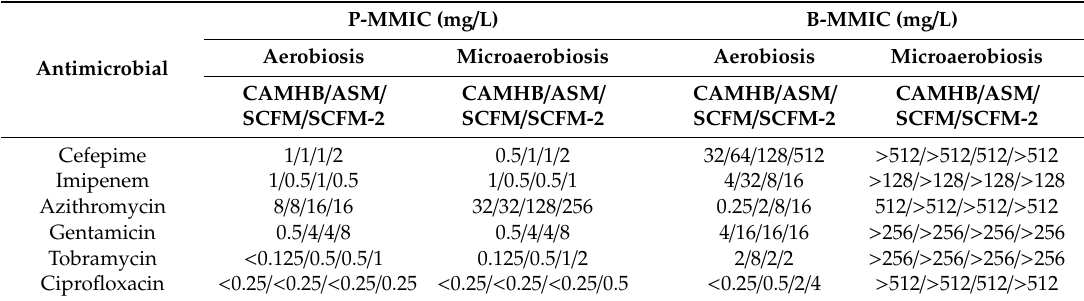
Table 1. Planktonic and Biofilm Minimum Metabolic Inhibitory Concentrations of P. aeruginosa PAO1 reference strain using di ff erent culture media and growth conditions 1